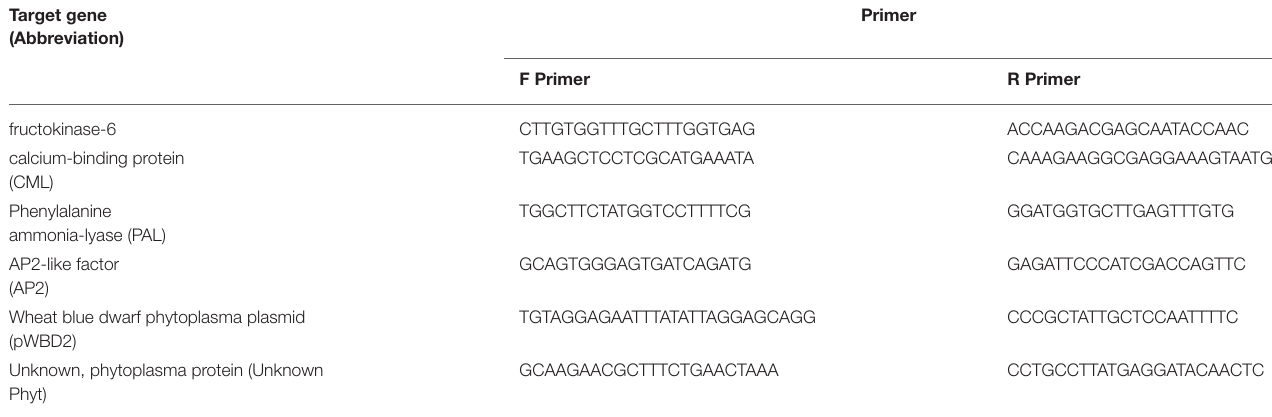
TABLE 1 | Target genes and primer sequences for real-time